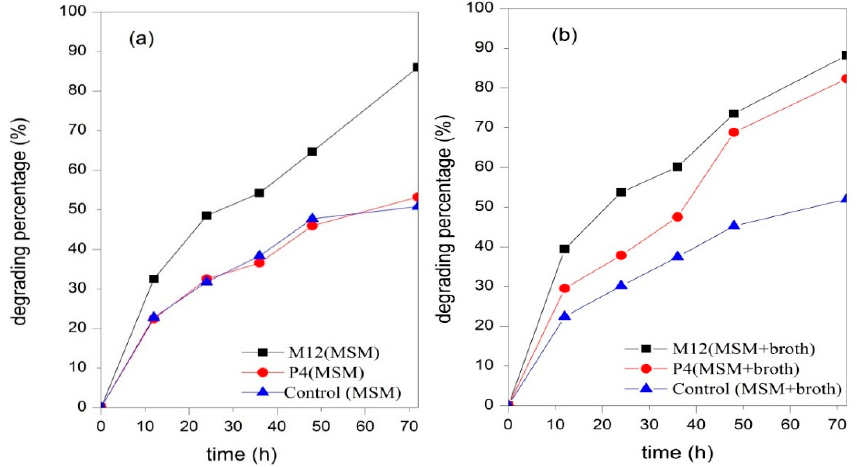
Figure 2. The degradation of UDMH in aqueous mineral salt medium (MSM): ( a ) UDMH as sole carbon source; ( b ) with the addition of broth medium.